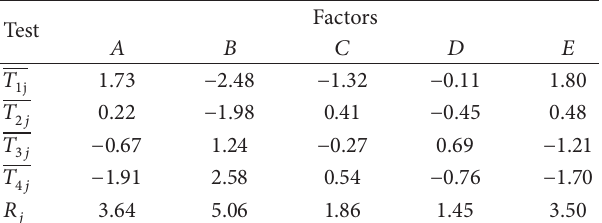
Table 3: Range analysis of experiment results.